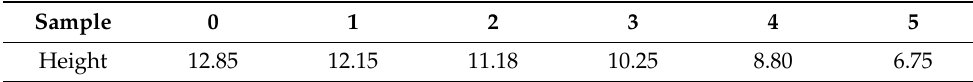
Table 3. Actual dimensions of rollers height after pressing